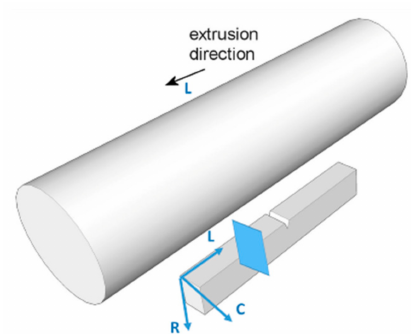
Figure 1. Test specimen in L–R (longitudinal loading–radial crack plane) orientation related to the extrusion direction (texture); the blue area marks orientation of TEM